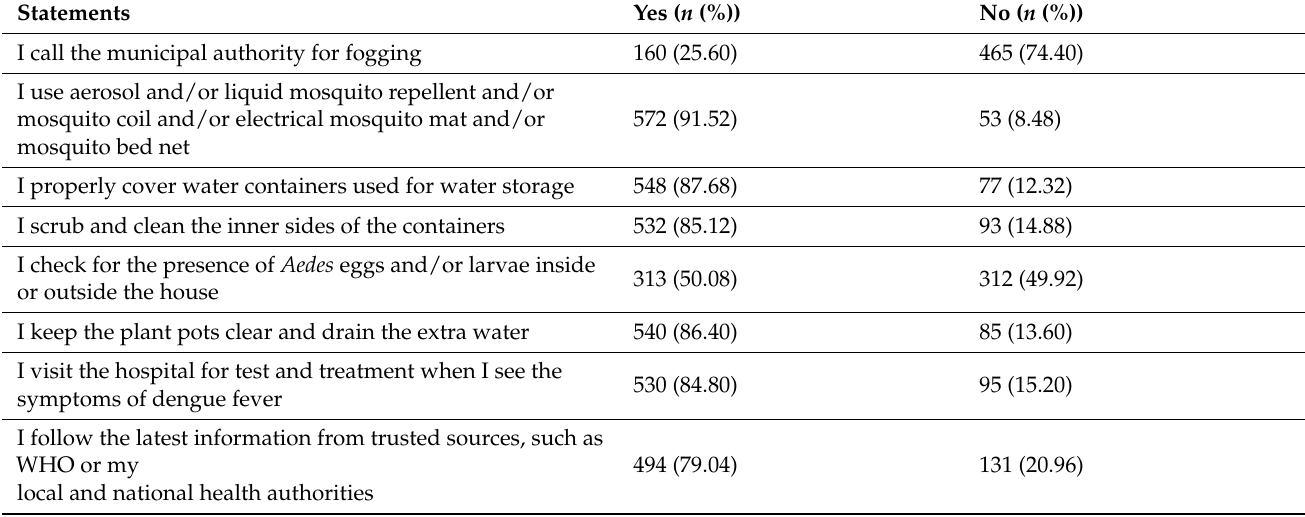
Table 4. Preventive practices towards dengue fever among university students of Dhaka city,